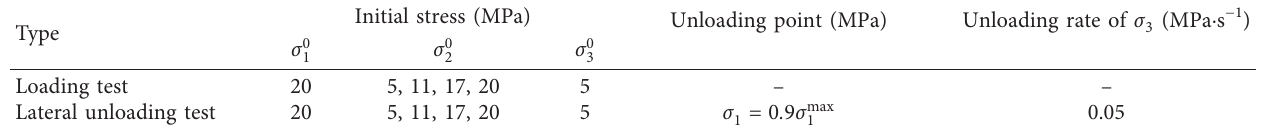
Table 1: Initial stress level.